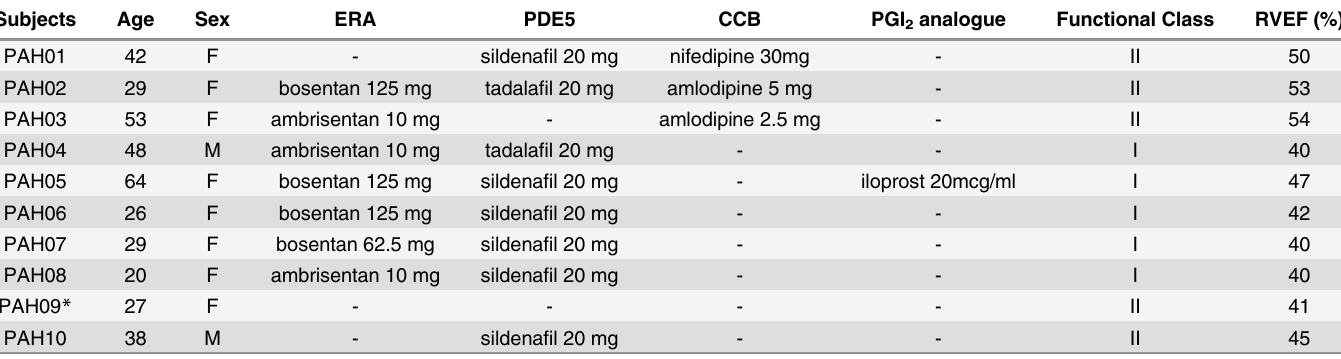
Table 1. PAH subject clinical characteristics and RV